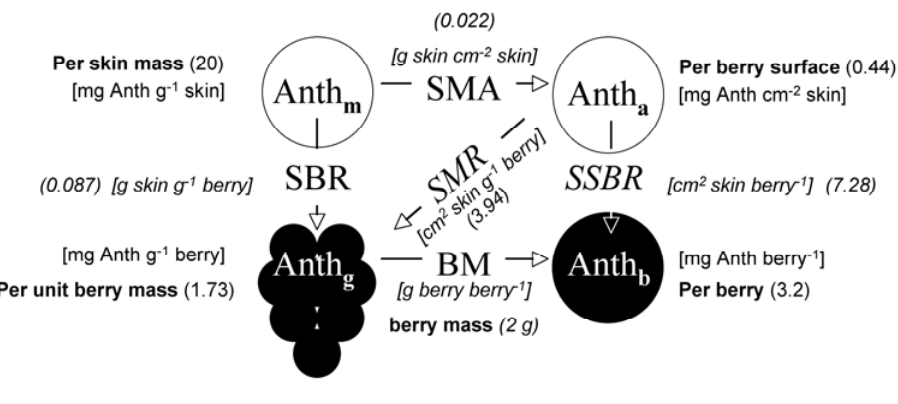
Figure 4. Four ways to express anthocyanin (Anth) content. Typical values for a mature 2-g Pinot Noir berry are indicated between round brackets and dimensions between square brackets. The conversion factors are SBR, skin-mass to berry-mass ratio, SMA, skin mass per area (fresh weight), BM, berry mass, SSBR, skin-surface to berry ratio (4.836 [BM/1.0817] 0.6667 ), SMR, berry surface-to-mass ratio (4.836 [BM/1.0817] − 0.3333 ). The value “1.0817” is the density of a berry having 20 °Brix. For an average molar mass of 500 gmol − 1 , 1 mg anthocyanins = 2 µmol, so all units can be transformed into µmols